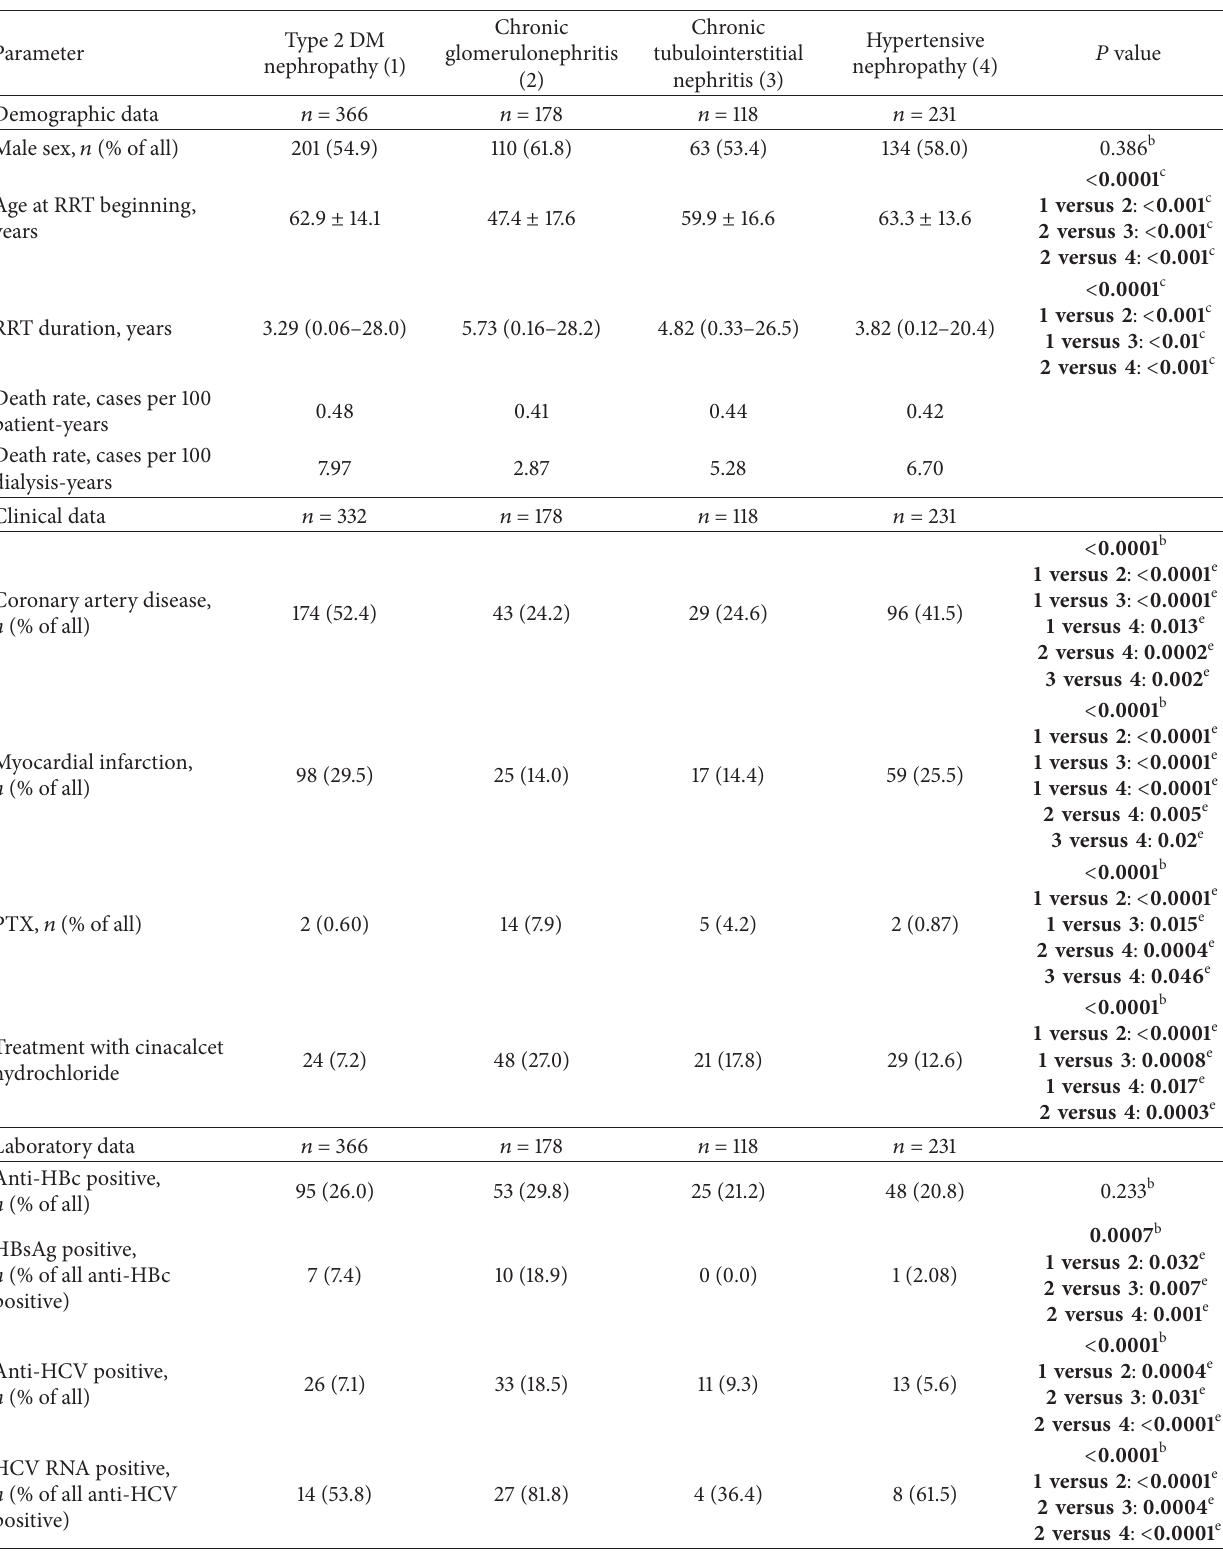
Table 3: Characteristics of hemodialysis patients grouped by a cause of